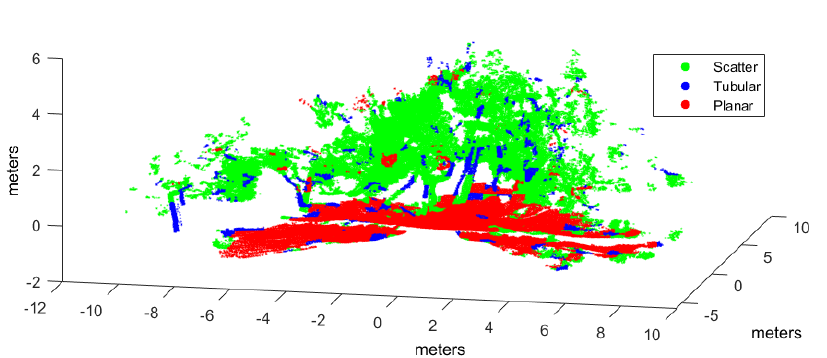
Figure 7. Natural_1 point cloud classified by NN with F 2 .